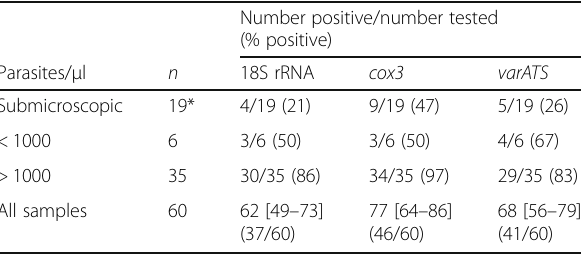
Table 1 Percentage of saliva samples that tested positive for P.